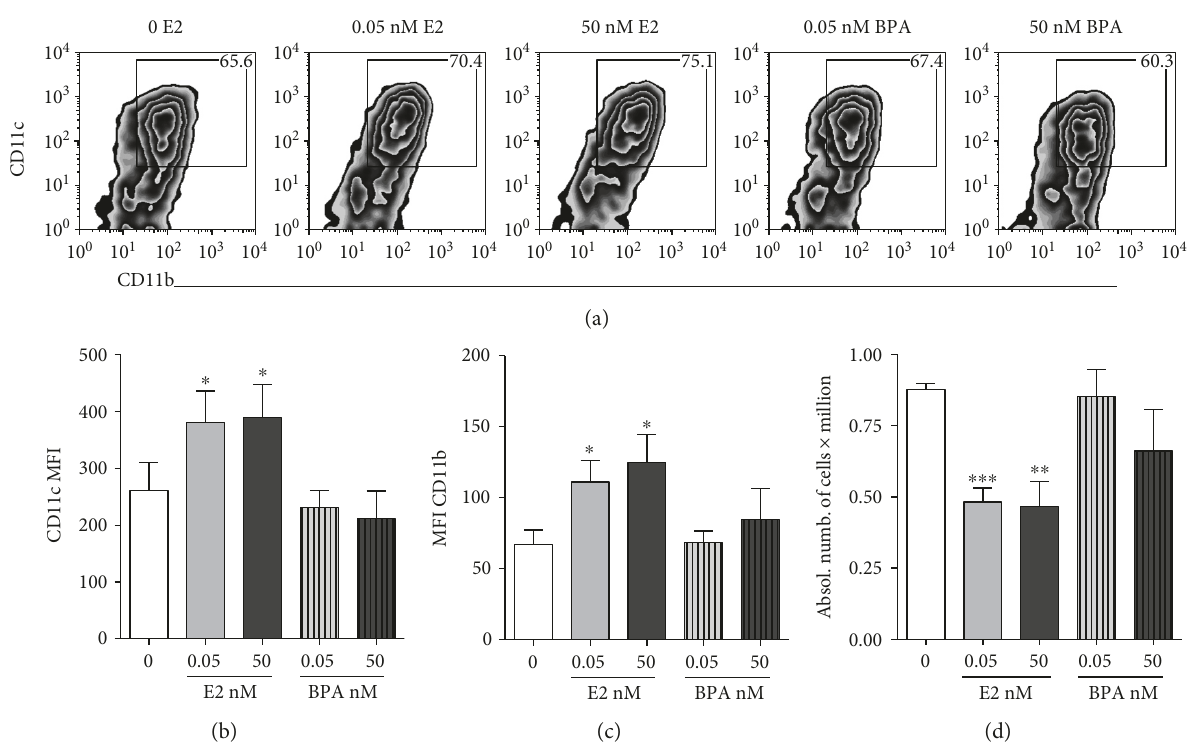
Figure 1: Estrogen enhances the di ff erentiation of cDCs while BPA does not a ff ect cDCs. (a – d) Days 6-7 of culture of cDCs grown in the absence or presence of low (0.05 nM) and high doses (50 nM) of 17beta-estradiol (E2) or low (0.05 nM) and high doses (50 nM) of BPA. (a) Representative plot of the fl ow cytometry analysis of the cDC di ff erentiation markers CD11c and CD11b expression in the alive gate of cDCs. (b) MFI of CD11c expression. (c) MFI of CD11b expression, at days 6-7 of culture. (d) Results of manual cell counts of cells alive in the same DC cultures in which dead cells positive for the trypan blue staining were excluded; the results are averages and SE of four experiments conducted with four independent BMDC cultures. ∗ represents p < 0 05 , ∗∗ for p < 0 01 , and ∗∗∗ for p < 0 001